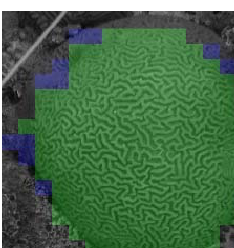
Figure 8. Effects of morphological filtering on classification results. ( Left ) The violets are misclassifications, which are removed after morphological filtering ( right ).